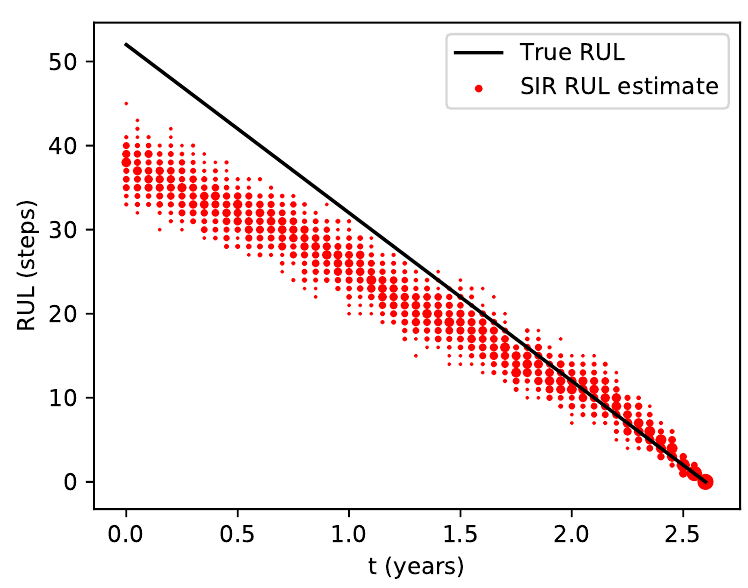
Figure 8. RUL prediction with time-varying pump power—SIR filter (dot size represents